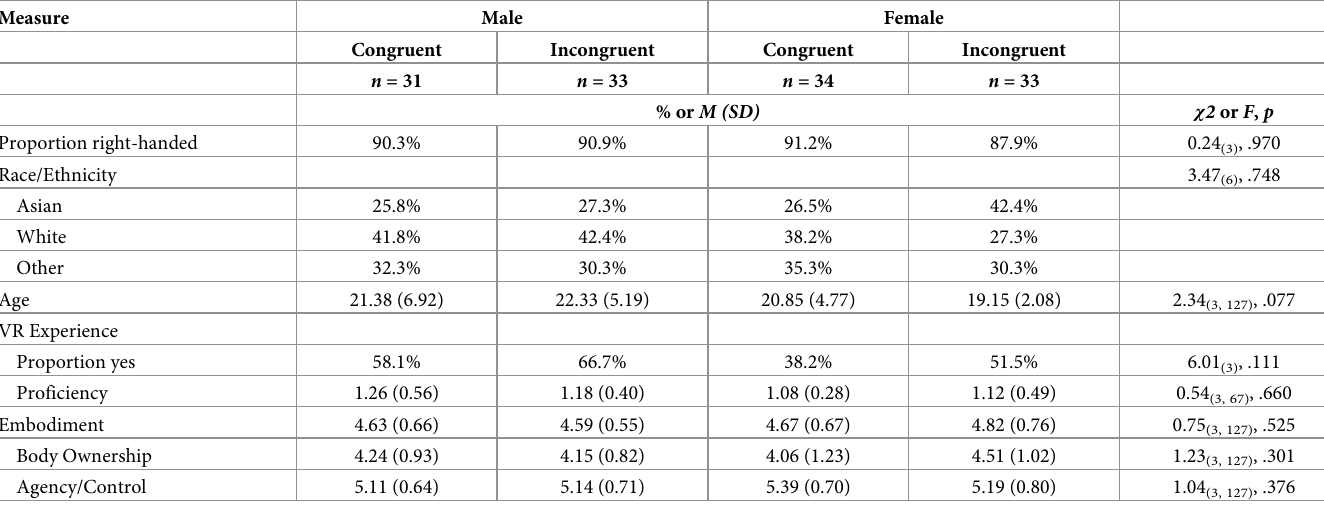
Table 7. Participant demographic characteristics by experimental condition in Study